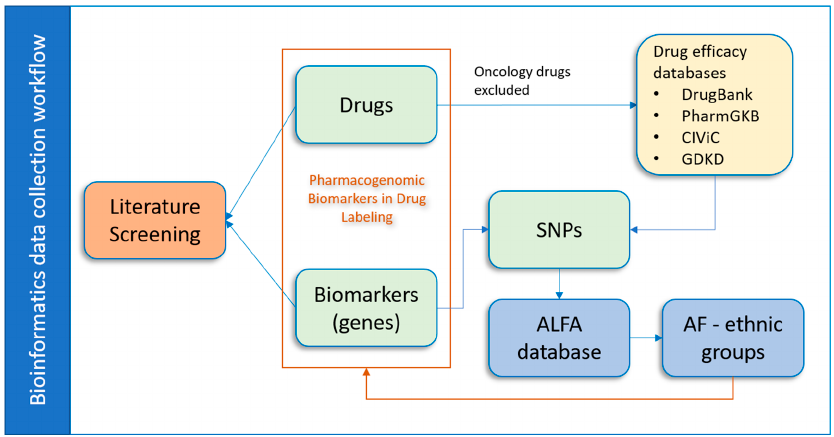
Figure 1. Overall data collection workflow. The paired PGx biomarkers and drugs were